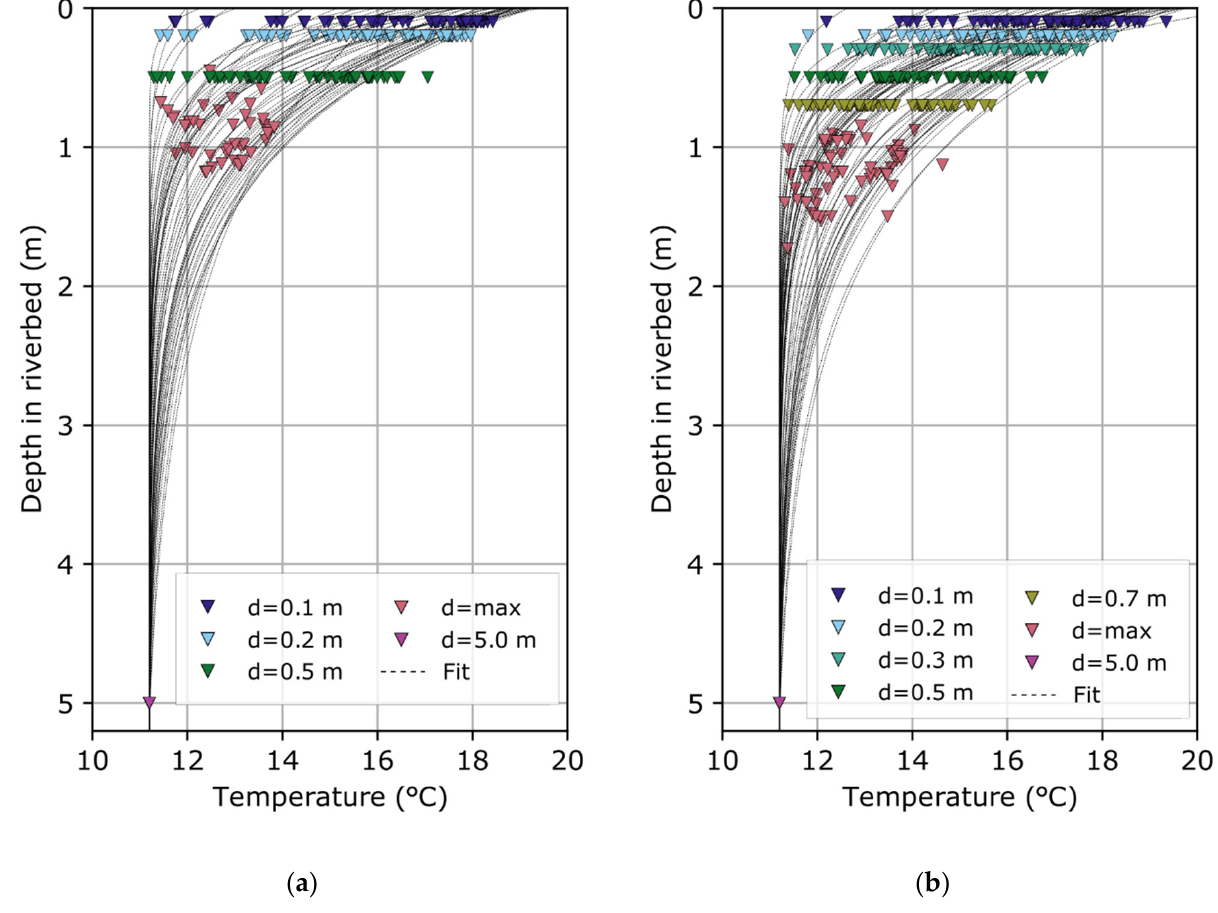
Figure 3. The plot of measured riverbed temperatures and riverbed profiles fitted with the analytical solution of Bredehoeft and Papadopulos [32]. ( a ) Downstream section and ( b ) upstream section.